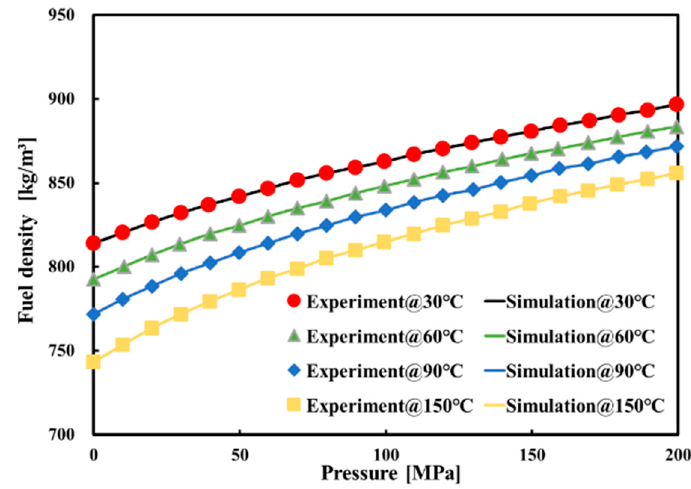
Figure 5. ρ calculated with Equation (1) compared with experimental data from [22].